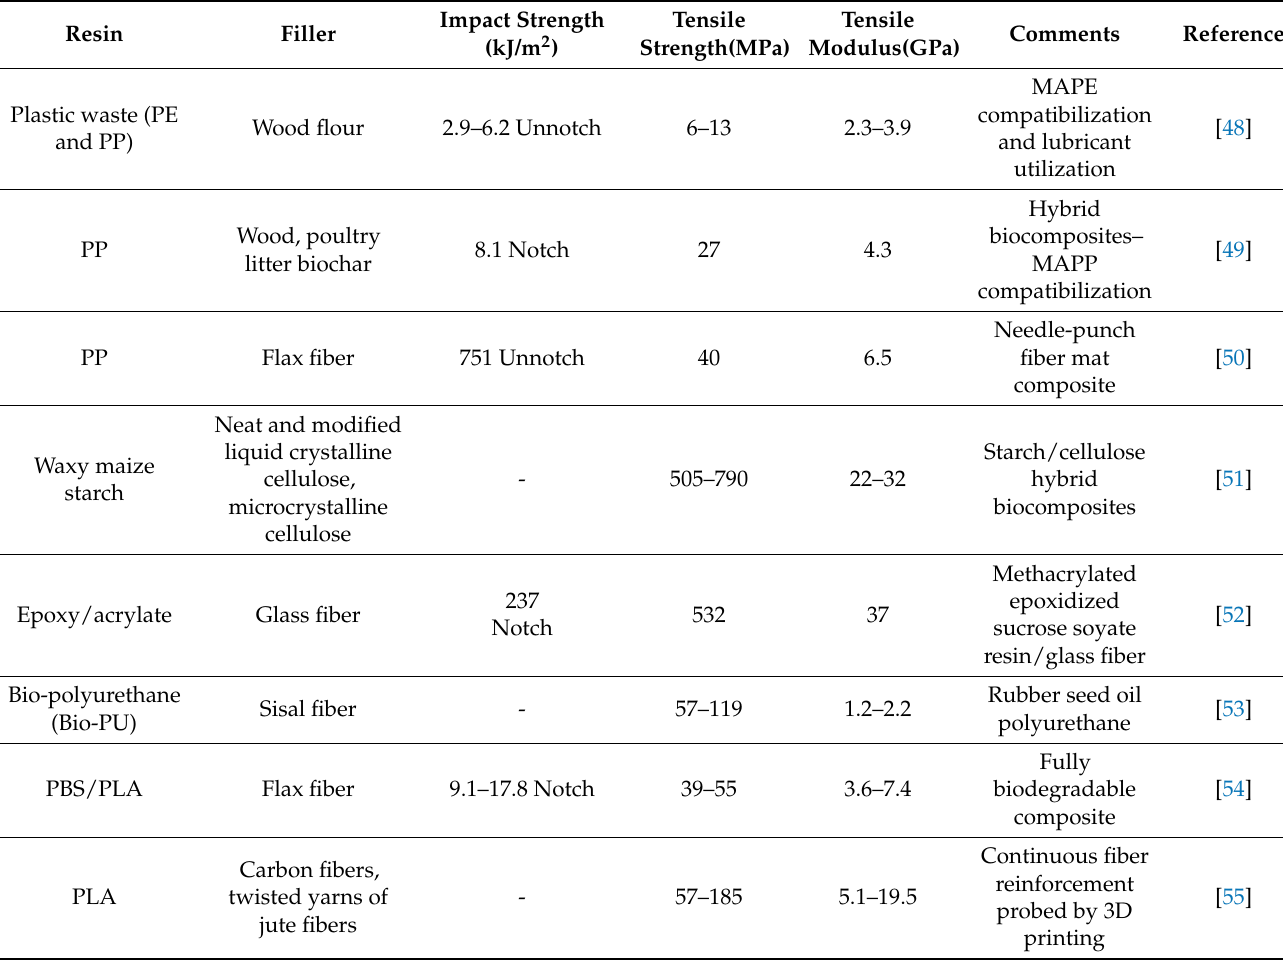
Table 5. Properties of representative biocomposites and their hybrids with or without maleic anhydride–grafted polyethy- lene (MAPE) or polypropylene (MAPP)